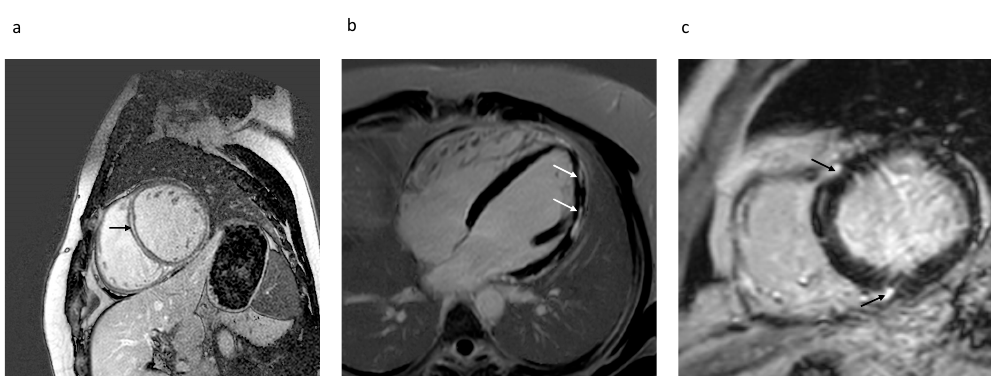
Figure 1. Different late gadolinium enhancement (LGE) patterns in non-ischemic cardiomyopathy (NICM). ( a ) Septal midwall LGE in short-axis view; ( b ) subepicardial patchy LGE of the lateral wall in four-chamber long-axis view; ( c ) patchy LGE at right ventricular (RV) insertion points in short-axis view.